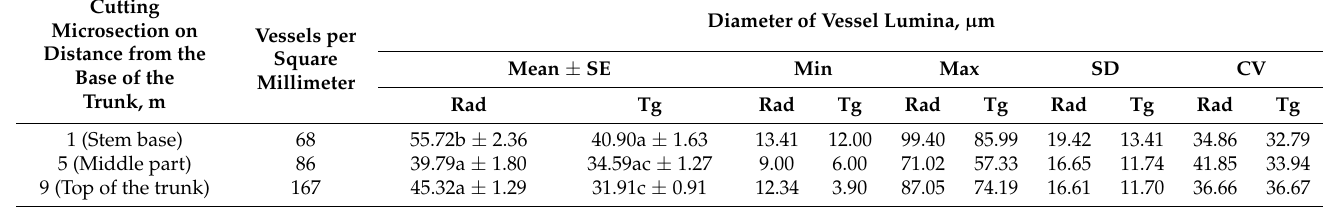
Table 3. Several parameters of vessels of Populus tremula L. stemwood measured on a transverse microsection depending on the different distances from the base of the